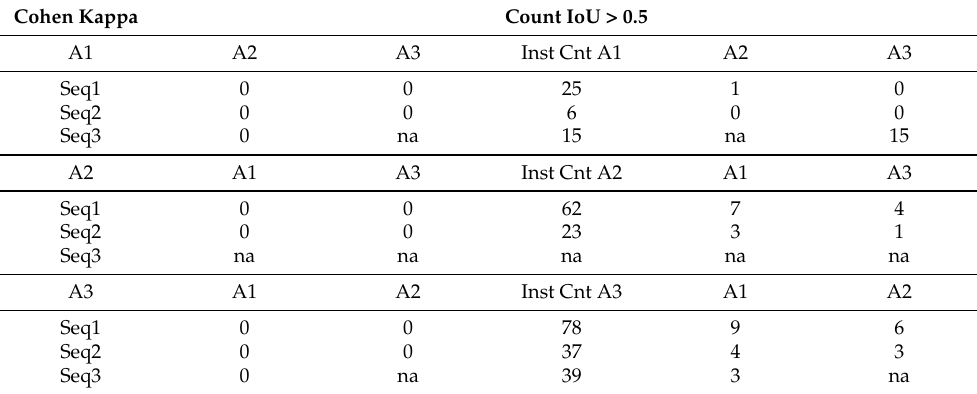
Table 5. Cohen Kappa Score between each annotator pair with a single annotator as reference annotator (left-most column). Additionally, the total number of instances per reference annotator with counts of overlap where IoU is greater than 0.5 for each